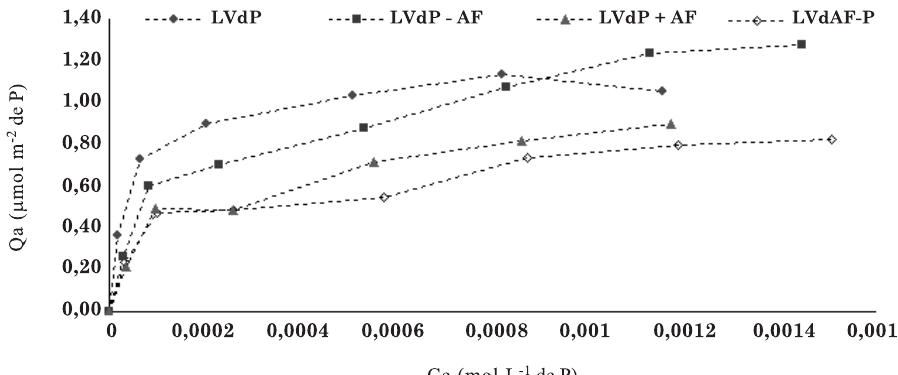
fúlvico.Figura 2. Isotermas de adsorção de fósforo sobre fração argila de Latossolo Vermelho distrófico (LVd)